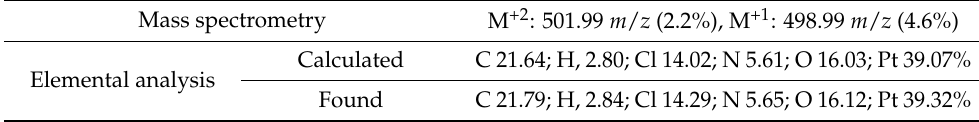
Table 1. Mass spectrometry and elemental analyses of asplatin (C 9 H 14 Cl 2 N 2 O 5